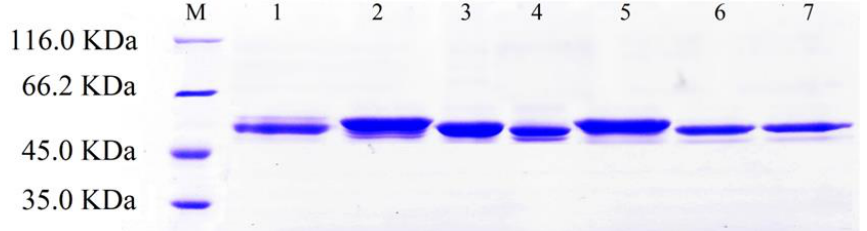
Figure 3. Sodium dodecyl sulphate-polyacrylamide gel electrophoresis (SDS-PAGE) analysis of the purified wild-type VpPLD and its corresponding mutants. Lane M, molecular mass marker (kDa); lane 1, purified (His) 6 -VpPLD-WT; lane 2, purified (His) 6 -VpPLD-Δ469-487; lane 3, purified (His) 6 - VpPLD-Δ451-487; lane 4, purified (His) 6 -VpPLD-Δ434-487; lane 5, purified VpPLD-(His) 6 -WT; lane 6, purified VpPLD-(His) 6 -Δ1-25; lane 7, purified VpPLD-(His) 6